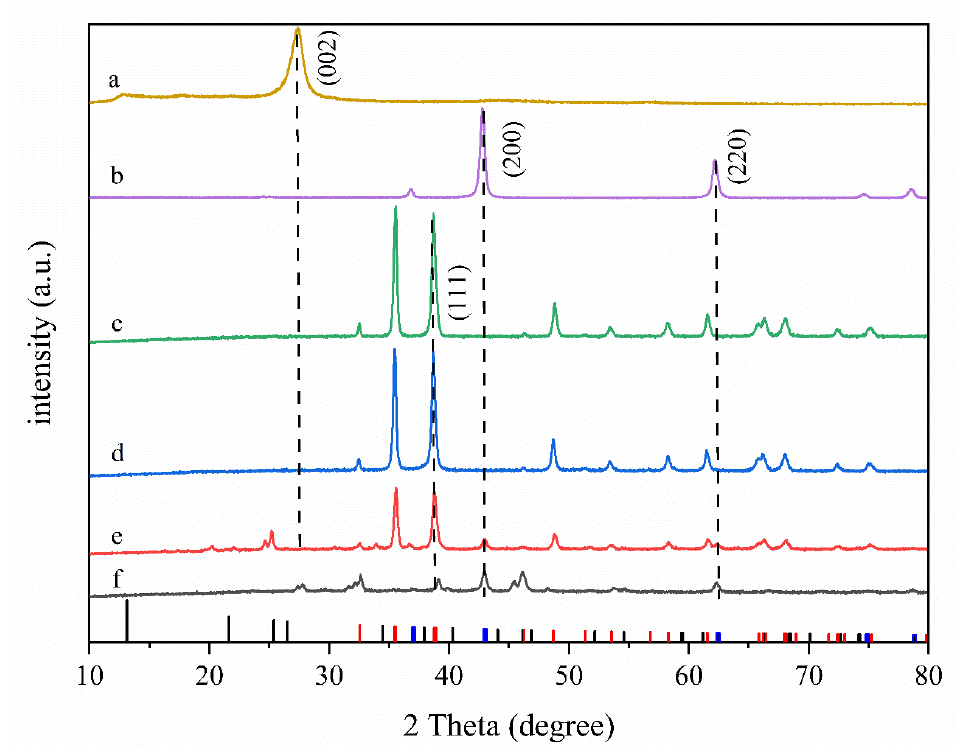
Figure 3. XRD spectra of different catalysts, g-C 3 N 4 , M/g-C 3 N 4 , C/g-C 3 N 4 , used CM/g-C 3 N 4 , fresh CM/g-C 3 N 4 and CM. Black: g-C 3 N 4 (JCPDS: 87-1526); Red: CuO (JCPDS: 80-1916); Blue: MgO (JCPDS: 79-0612).